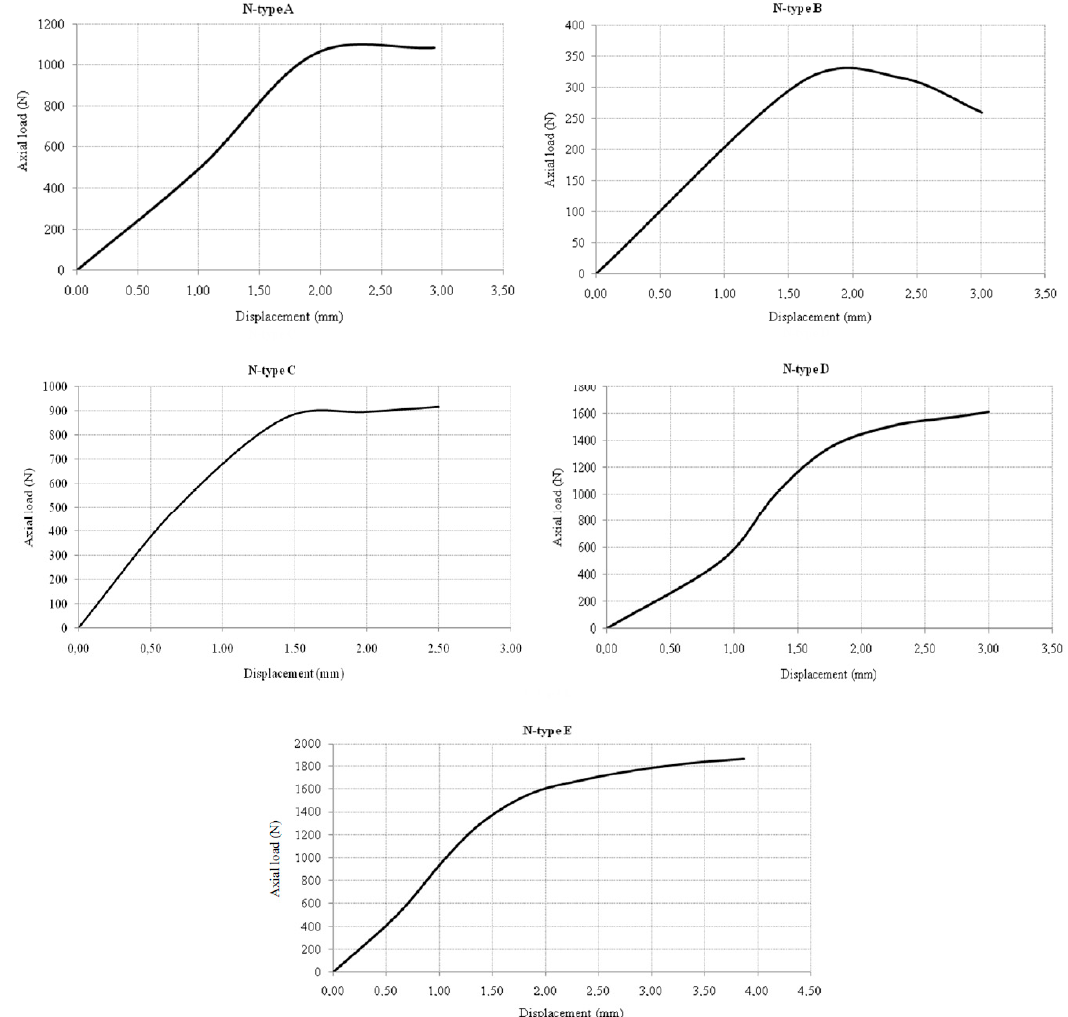
Figure 10. Axial load N (N)—vertical displacements w (mm) from the experimental tests.